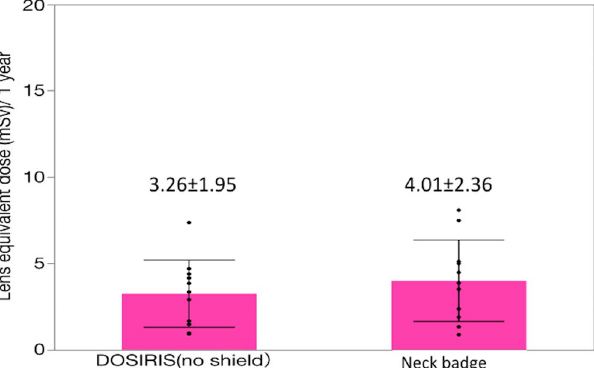
Figure 6. Estimated mean ± SD annual lens dose (EAED) determined by eye dose (DOSIRIS) measurements and neck badge dose measurements in 11 IC nurses. ( P =